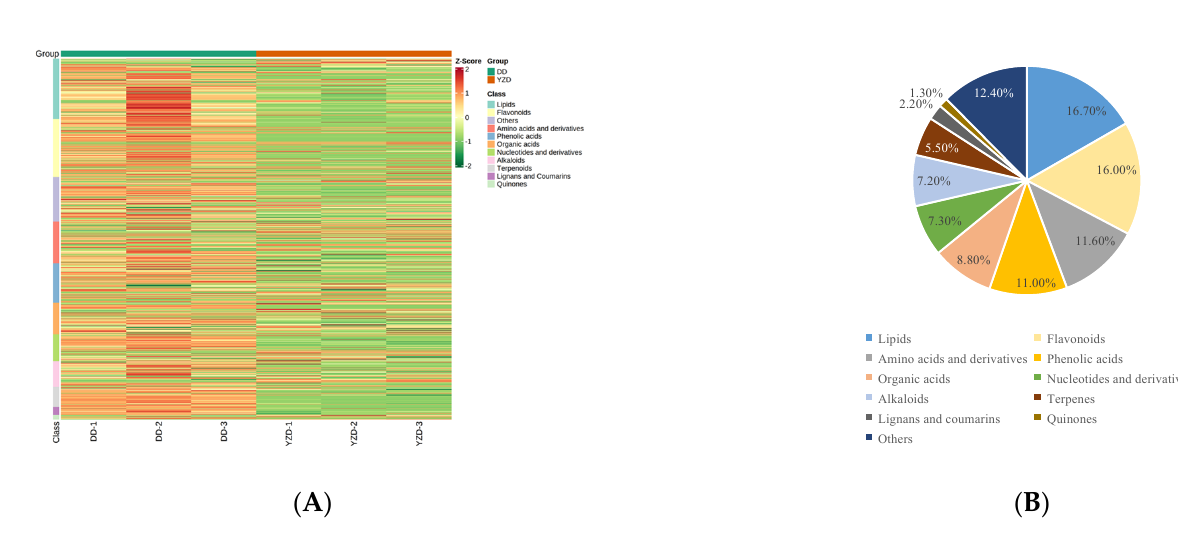
Figure 4. Metabolites in DD and YZD. ( A ) Heatmap of the metabolites in DD and YZD. The colour indicates the level of accumulation of each metabolite, from low (green) to high (red). The Z-score represents the deviation from the mean by standard deviation units. ( B ) Types and proportions of the identified metabolites from DD and YZD. Table 1. Overview of the identified metabolites in DD and YZD.